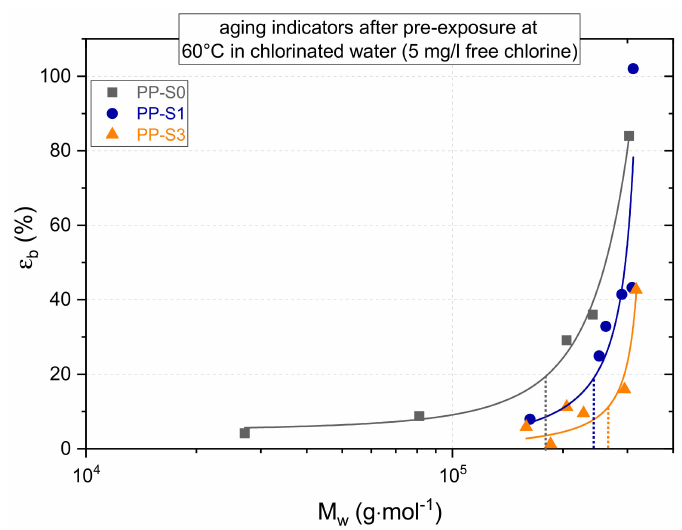
Figure 7. Dependence of strain at break values ( ε b ) of the three aged PP grades on the mean molar mass (M w ) of these materials in the aged state with indications on the vertex (dotted line) of the fit curvature representing the characteristic embrittlement mean molar mass of the materials (PP-S0: 180